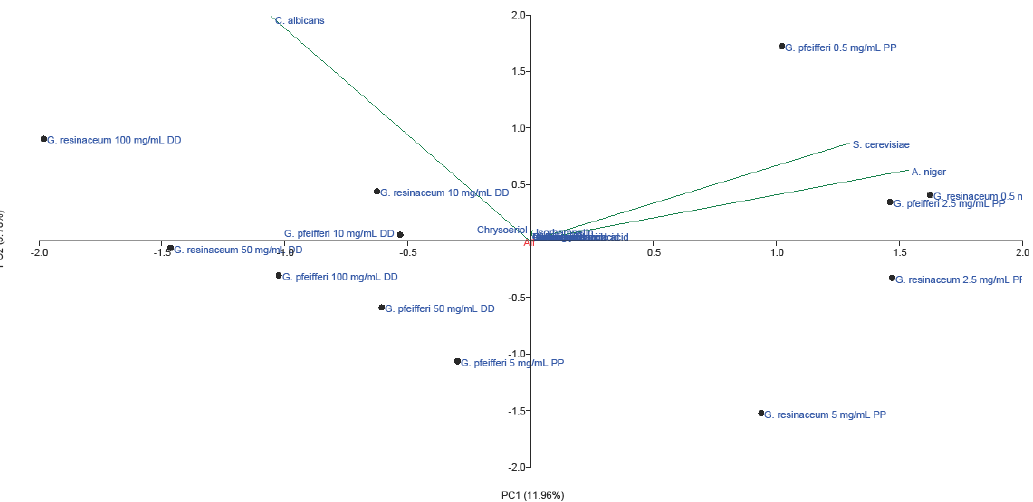
Figure 4. PCA of quantified phenolic compounds and antifungal activity of EtOH extracts of G. pfeifferi and G. resinaceum . Abbreviations: DD—disk ‐ diffusion method; PP—pour plate method. The first axes (PC1) accounted for 11.96% and the second (PC2) for 5.78% of the to ‐ tal variability. Stronger separation was conducted in the horizontal plane of the PC2, with all phenolics and isorhamnetin loading in the II quadrant. This indicates that these compounds positively correlated with high AF activity of tested extracts against A. niger and S. cerevisiae , using the pour plate method. Low AF effect of these extracts obtained against C. albicans (Figures 1 and 2) could be a consequence of low amounts of chrysoe ‐ riol, detected only in G. pfeifferi [33], since this compound positively correlated with disk ‐ diffusion activity of both Ganoderma species against this pathogen. A total variance of 62.59% was observed for AV activity of all four Ganoderma spe ‐ cies, with PC1 of 36.77% and PC2 of 25.82%. G. lucidum , G. pfeifferi and G. applanatum (EtOH extract and EtOH extract solution in 5% DMSO) were generally separated from G. resinaceum extracts and H 2 O extracts (Figure 5).